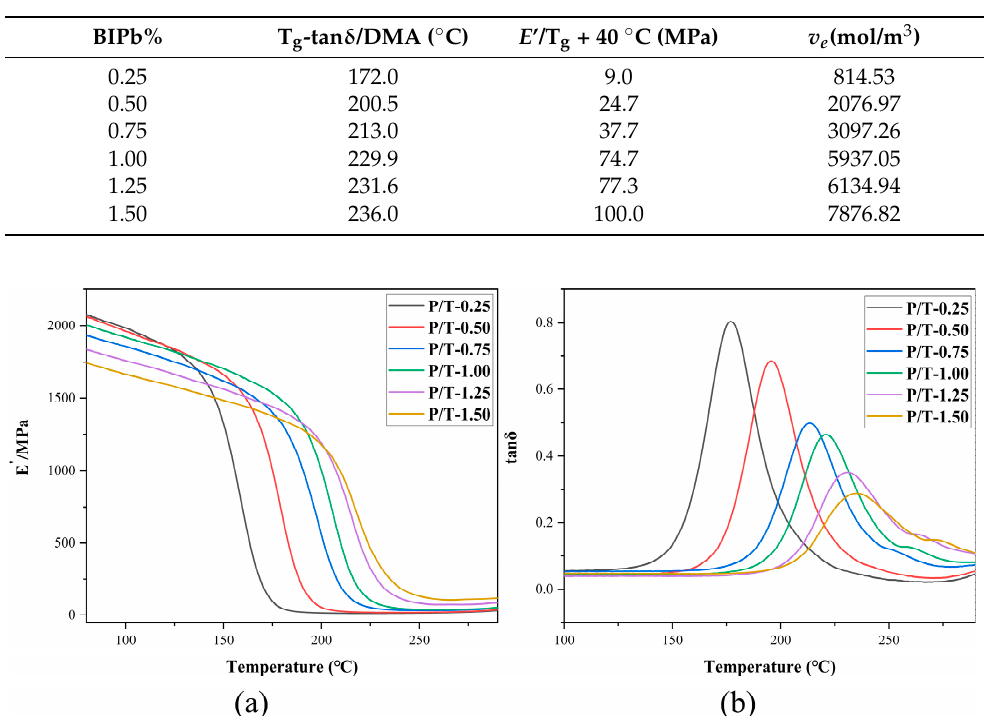
Figure 9. Positron lifetime spectra measured for cured samples.